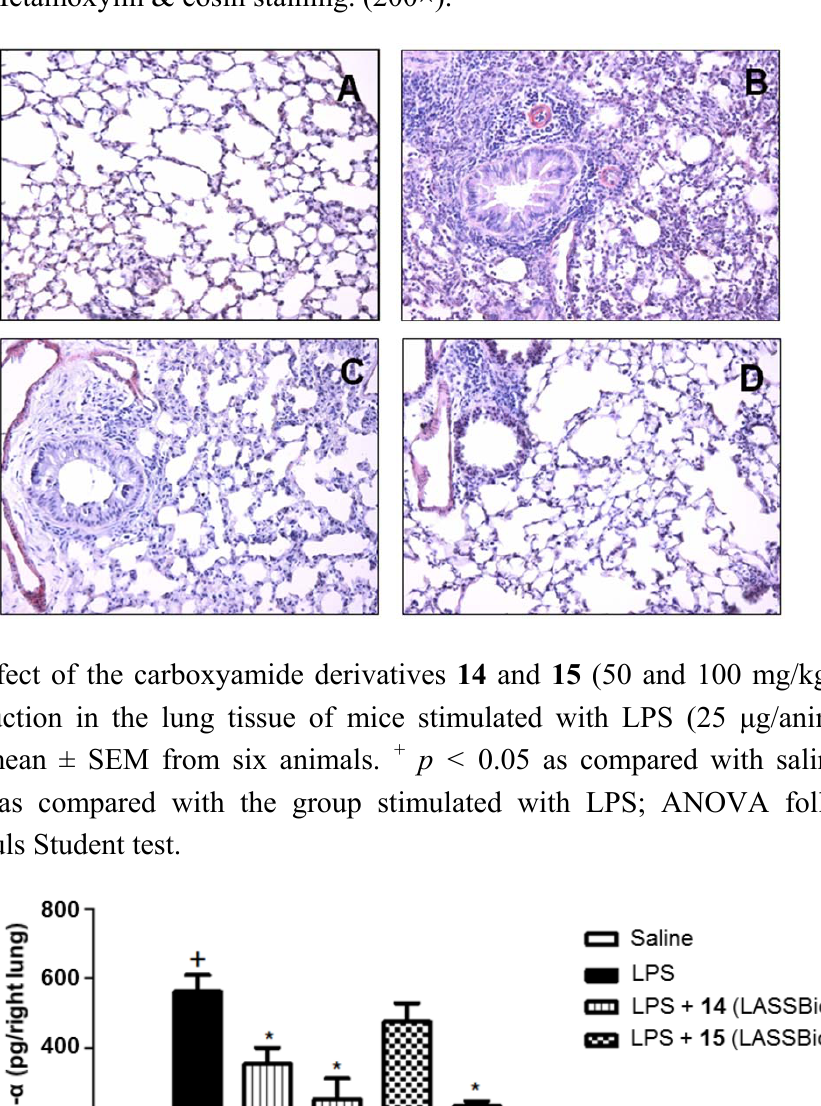
Figure 6. Light photomicrographs of lung tissue sections from mice stimulated with LPS (25 μ g/animal, i.n.). ( A ) saline; ( B ) LPS; ( C ) LPS + 14 ; (D) LPS + 15 . The effect of carboxyamide derivatives 14 and 15 (100 mg/kg; i.p.) was evaluated 24 h after LPS stimulation. Hetamoxylin & eosin staining. (200×).